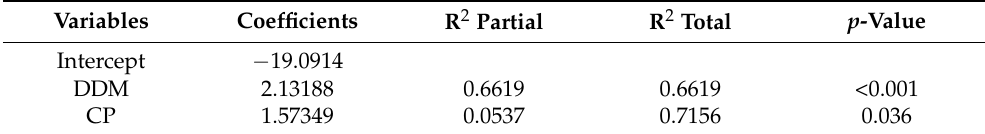
Table 6. Metrics of the multiple regression analysis with the milk yield as dependent variable and digestible dry matter (DDM, kg) and crude protein (%) as predictors. Variables